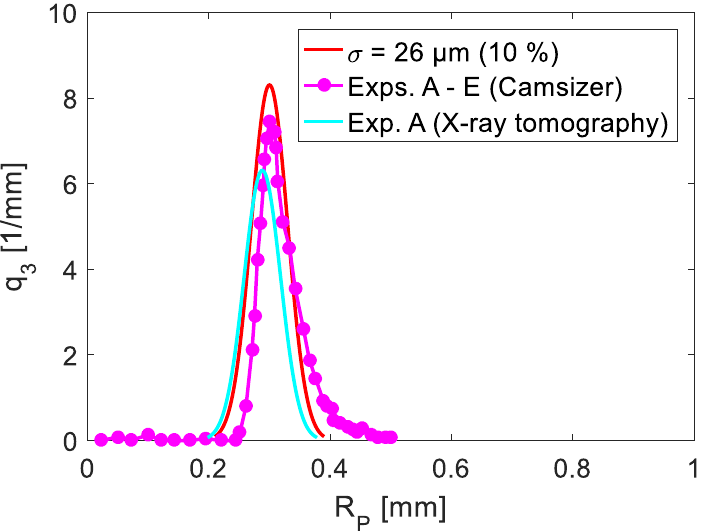
Figure A1. PSD of glass beads measured by Camsizer and primary particles determined from X-ray tomography data of individual agglomerates of Exp. A.